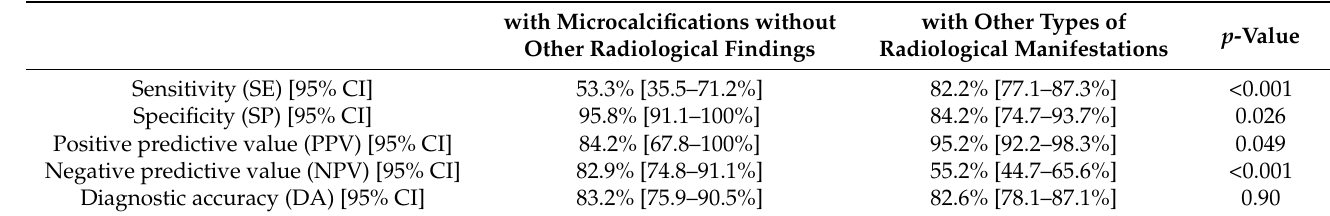
Table 3. Sensitivity, specificity, positive predictive value, negative predictive value, and diagnostic accuracy among lesions with microcalcification without other radiological findings and with other types of radiological manifestations. Scores 0 and 1 are predictive of benignity, and scores 2 and 3 are predictive of